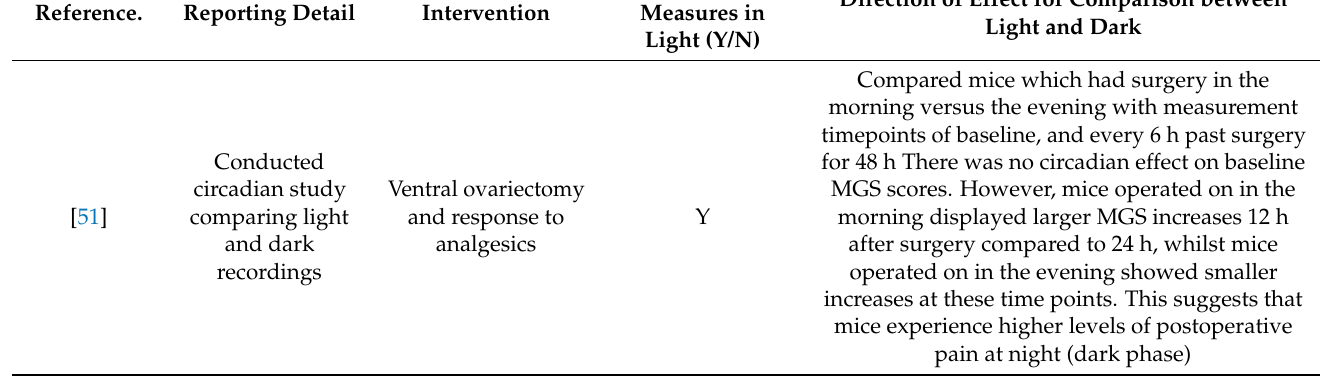
Table 3. Studies that utilised grimace scoring in the dark stage of the circadian cycle and the impact on scores were reported.